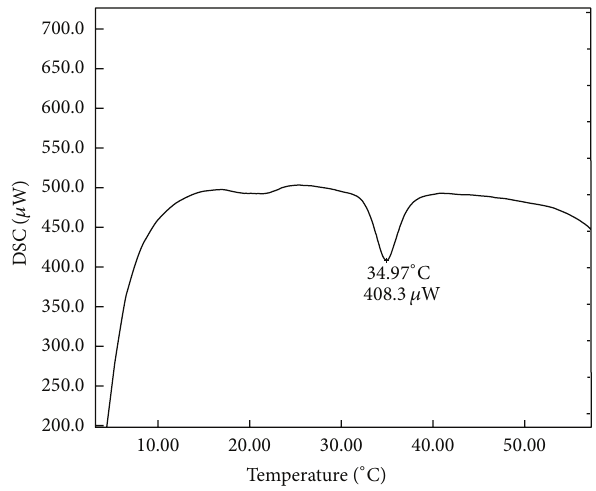
Figure 2: The typical DSC spectrum of the 1% concentration of TAC solution. Note that there are no peaks of 𝑇 corresponding to 𝑇